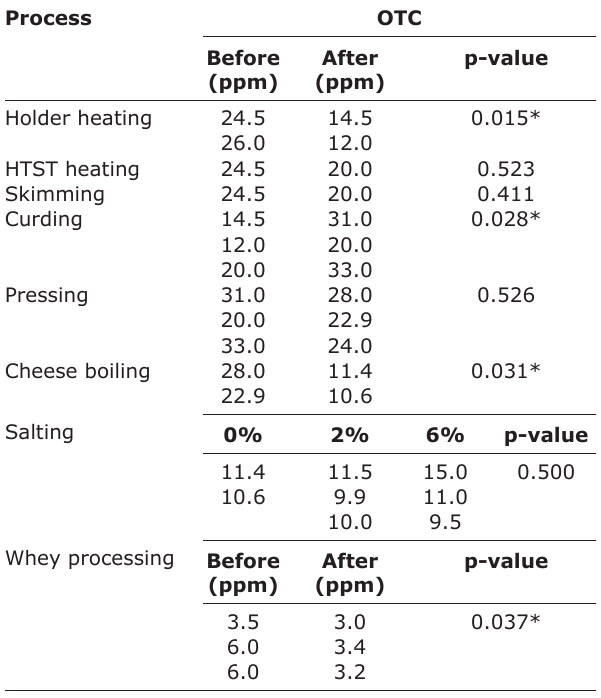
Table-1: Effect of different processes on OTC concentration. Process